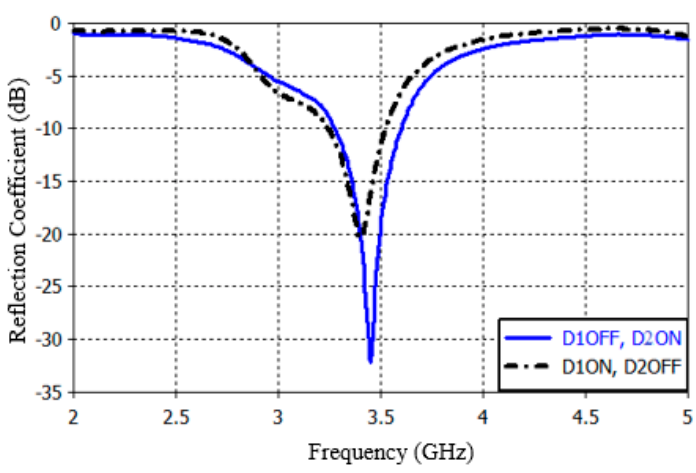
Figure 6. Measured reflection coefficients for the proposed reconfigurable antenna.